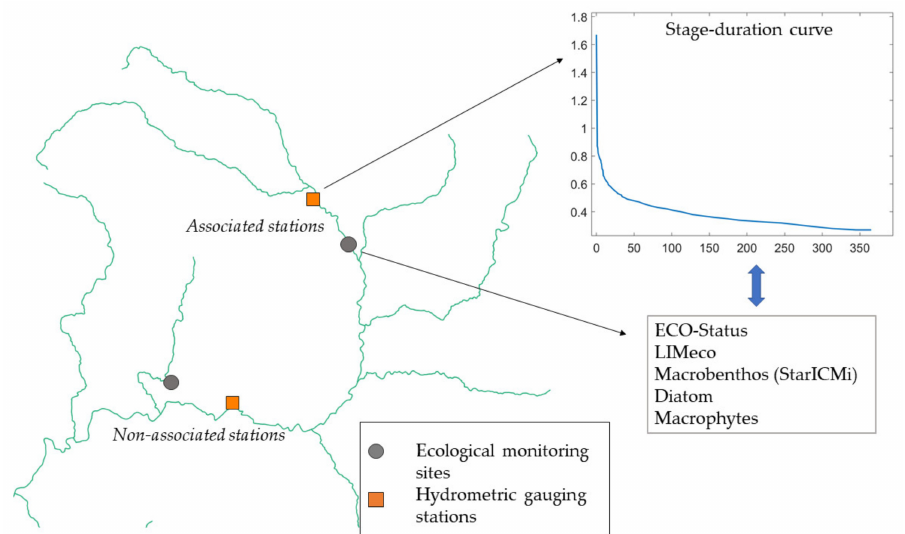
Figure 2. Example of GIS-based association of hydrometric gauging stations (SIR) and ecological monitoring sites (ARPAT). The top right panel shows the stage-duration curve with levels (Y-axis) expressed in m and duration in days (X-axis). The bottom right box lists the ecological indicators paired with each reference water level H i